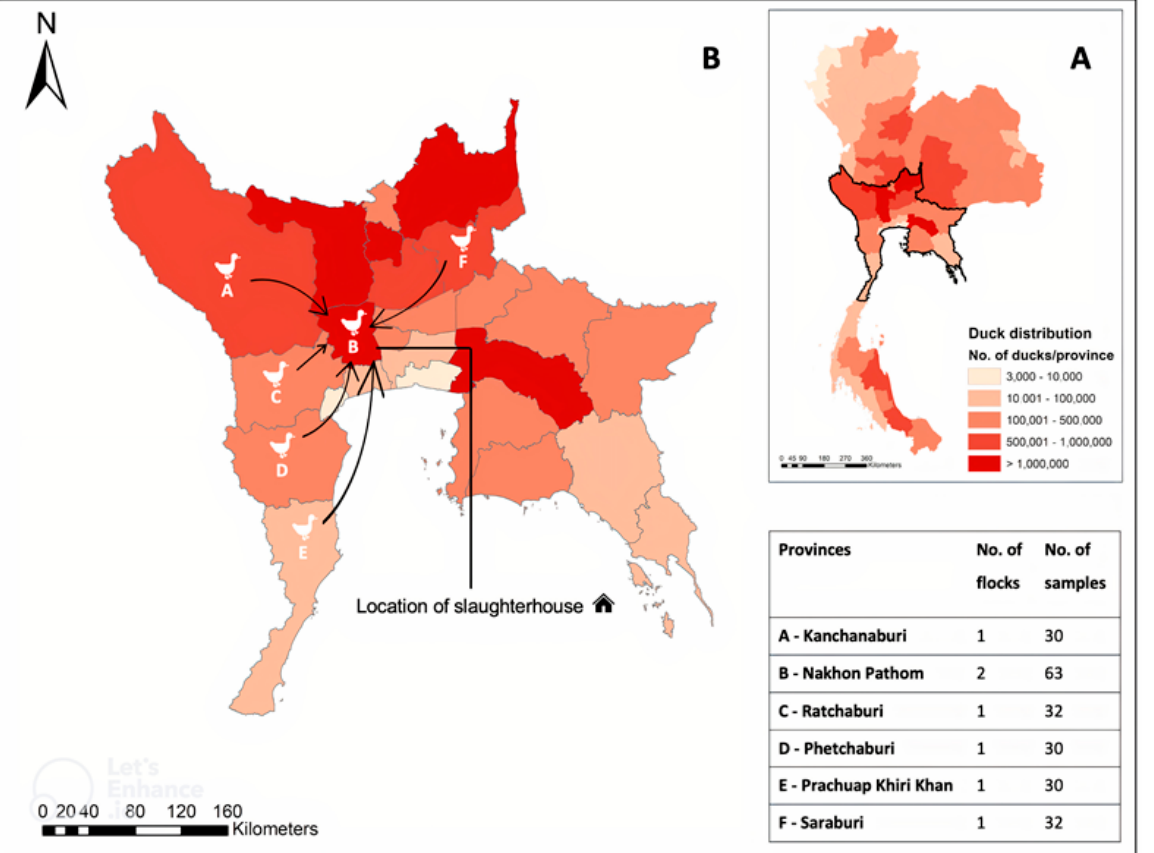
Figure 1. Study area: ( A ) distribution of free-grazing ducks in Thailand (13); ( B ) six investigated provinces with the number of flocks and ducks